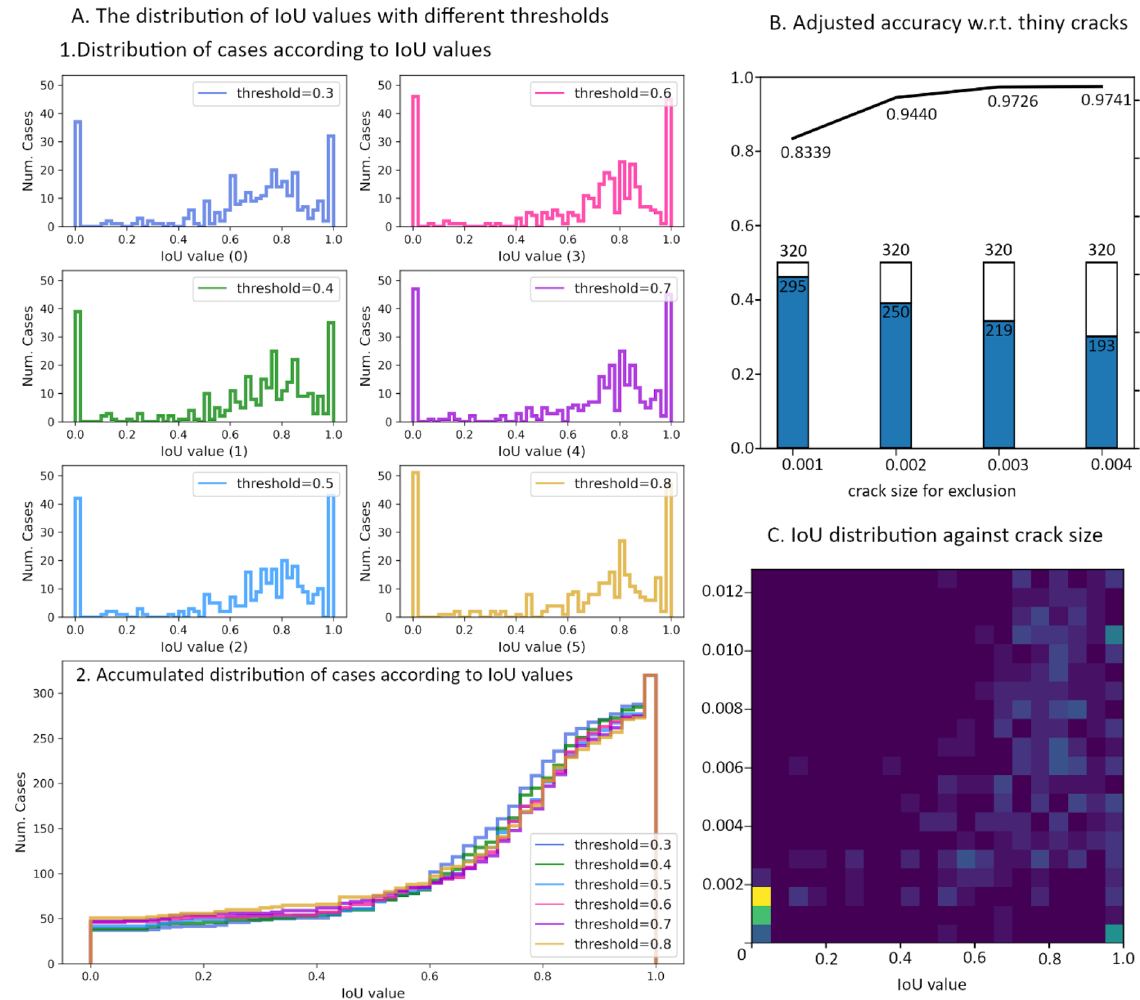
Figure 9. The relationship between crack size and evaluation metrics. The IoU values of 320 test cases are calculated by the model trained with γ = 0.4 and α = 0.75 . ( A ) 1. the 6 histograms of the IoU values that are calculated with 6 different binarization threshold ( T bin = 0.3, 0.4, 0.5, 0.6, 0.7, 0.8); 2. the accumulated histograms of the IoU values that are calculated with 6 different thresholds. ( B ) The adjusted accuracy for test data after excluding tiny crack cases. The line plot presents the accuracy that is re-calculated when excluding cases with crack size less than 0.001, 0.002, 0.003, and 0.004; the bar chat shows the number of samples after excluding the samples with tiny cracks against the total number of samples in test dataset. ( C ) IoU values distribution w.r.t crack